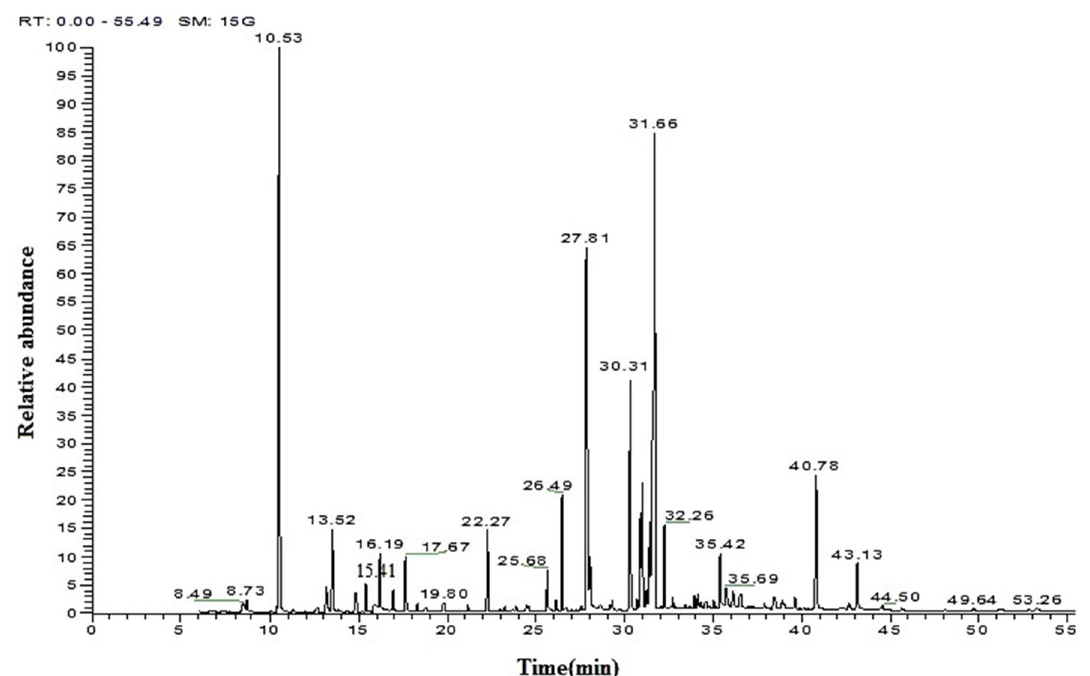
Fig. 1 Gas chromatogram of compounds extracted from pharmaceutical effluent